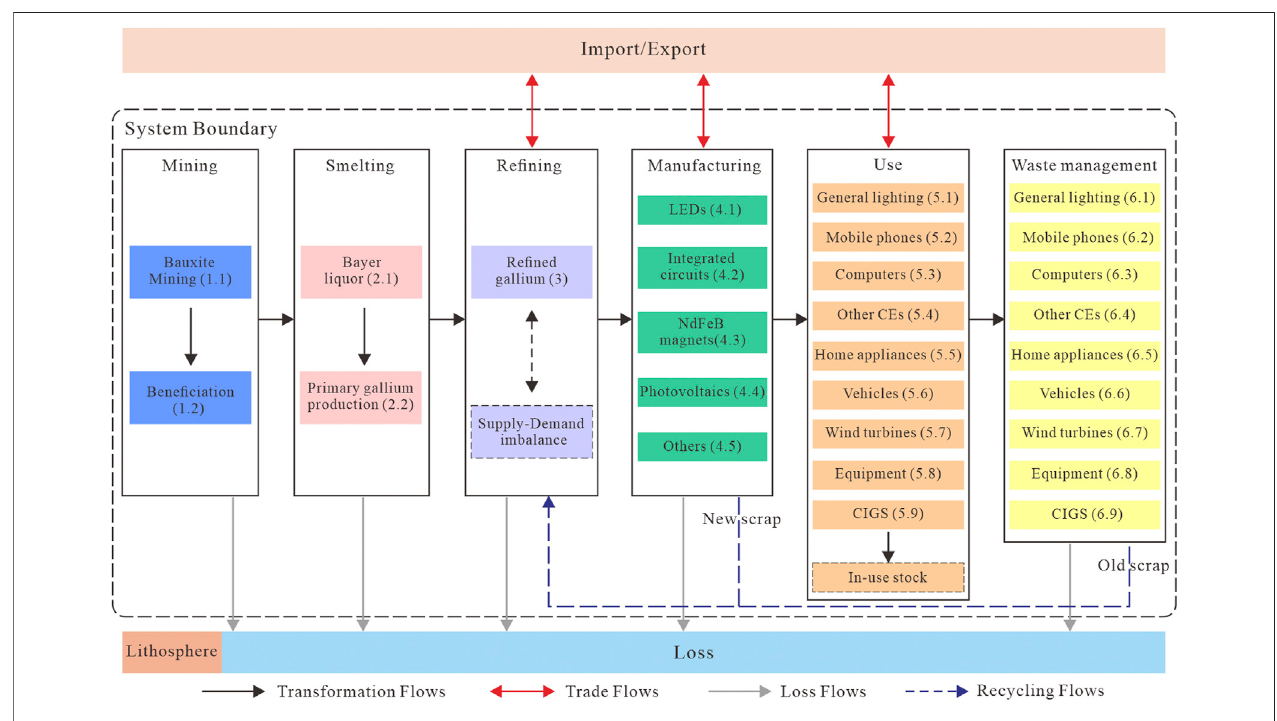
FIGURE 1 | Material fl ow analysis framework for gallium